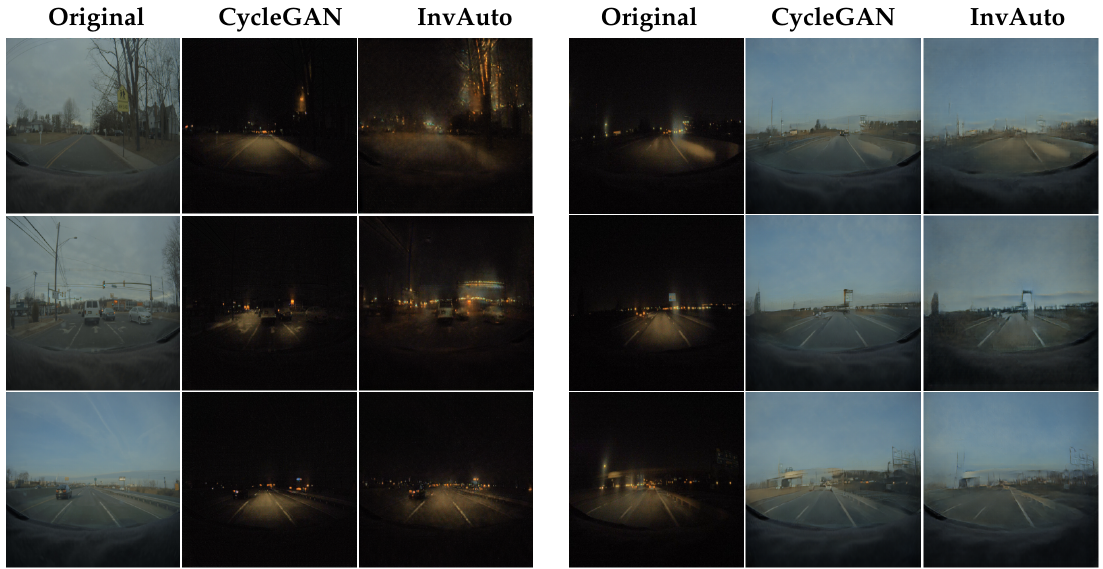
Figure 9. ( Left ) Experimental results with autonomous driving system: day-to-night conversion. Zoomed image is shown in Figure A11 in Appendix A. ( Right ) Experimental results with autonomous driving system: night-to-day conversion. Zoomed image is shown in Figure A12 in Appendix